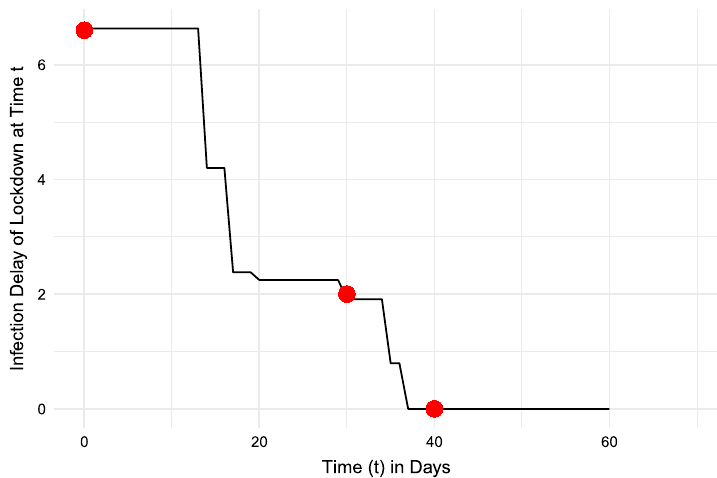
Fig. 5 Hypothetical infection delay curve for region-at-risk A caused by a lockdown, following an outbreak beginning in region B . At time t = 0 , location B would be the only infected region—as the outbreak location. At this time, a lockdown would allow region A to gain approximately 6.6 days (y-axis) until its first case of COVID-19. If the disease were to spread unmitigated until time t = 30 days, a lockdown would provide a gain of only 2 days before region A ’s first case. At the 40-day mark following an outbreak in region B , without any intervention, region A would already be infected. Thus, a lockdown intervention at this point would have no ability to delay the onset of infection, with a y-axis value of